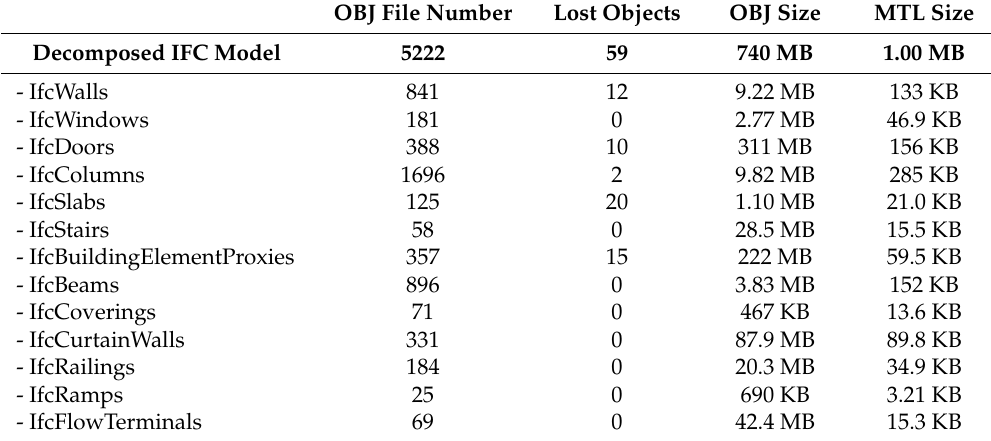
Table 3. Intermediate disk usage for each IFC type during the second IFC to OBJ step.